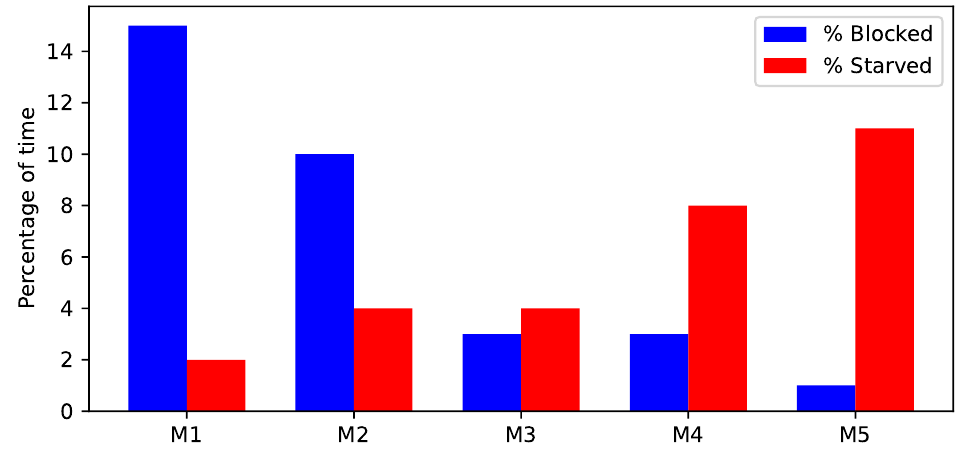
Figure 6. Example of Turning Point